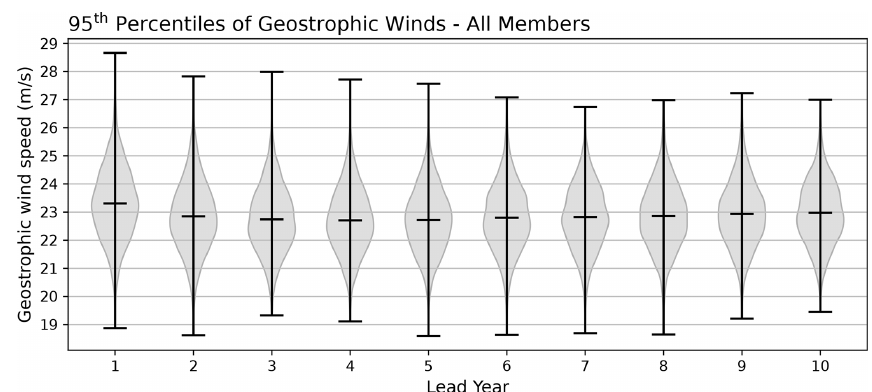
Figure 3. Violin plot of the distribution of annual 95th percentiles of geostrophic wind speeds from all members and all initializations, separated by lead year. Lead years increase from left to right along the x axis. The width of the violin indicates the normalized density for a certain wind speed. Horizontal dashes mark maxima, means, and minima for each lead